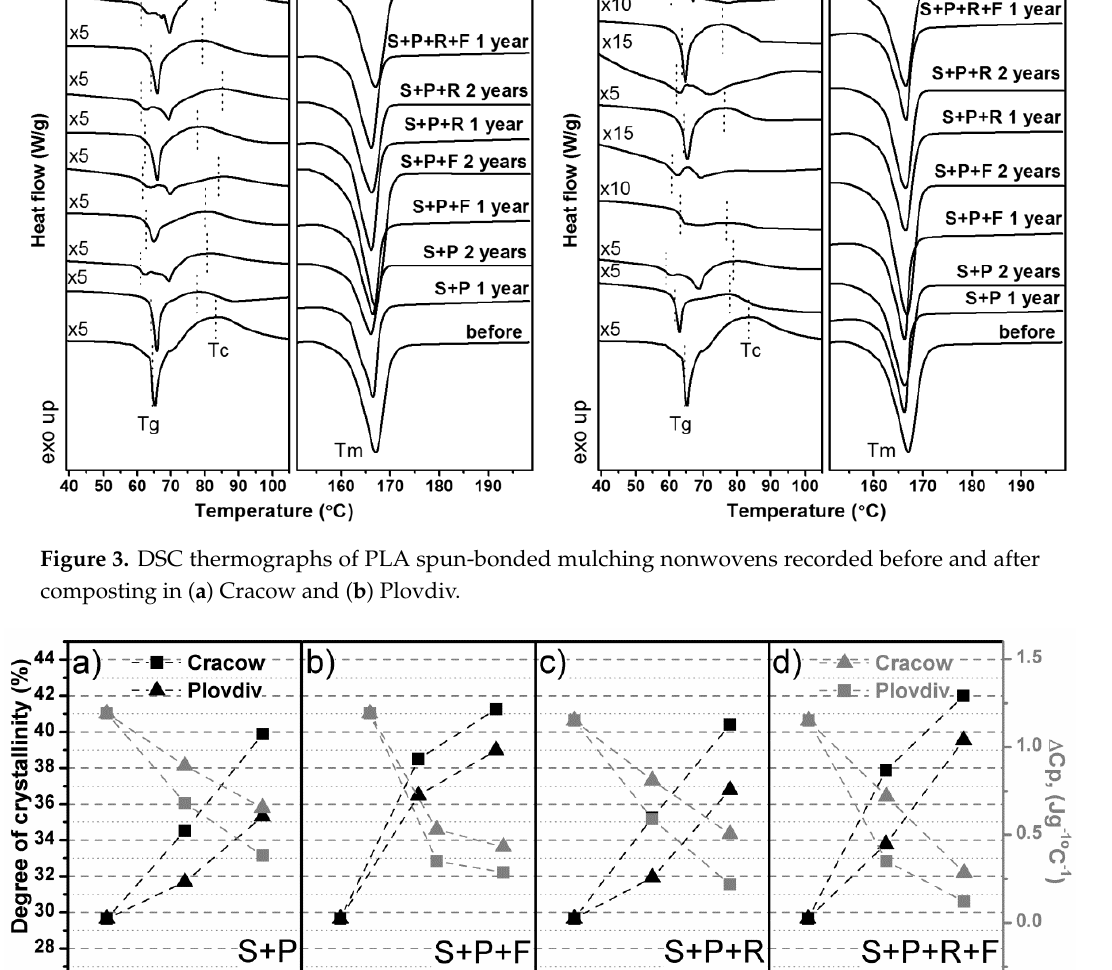
Figure 5. WAXS diffractograms of PLA spun-bonded mulching nonwovens before and after composting in ( a ) Cracow and ( b ) Plovdiv.